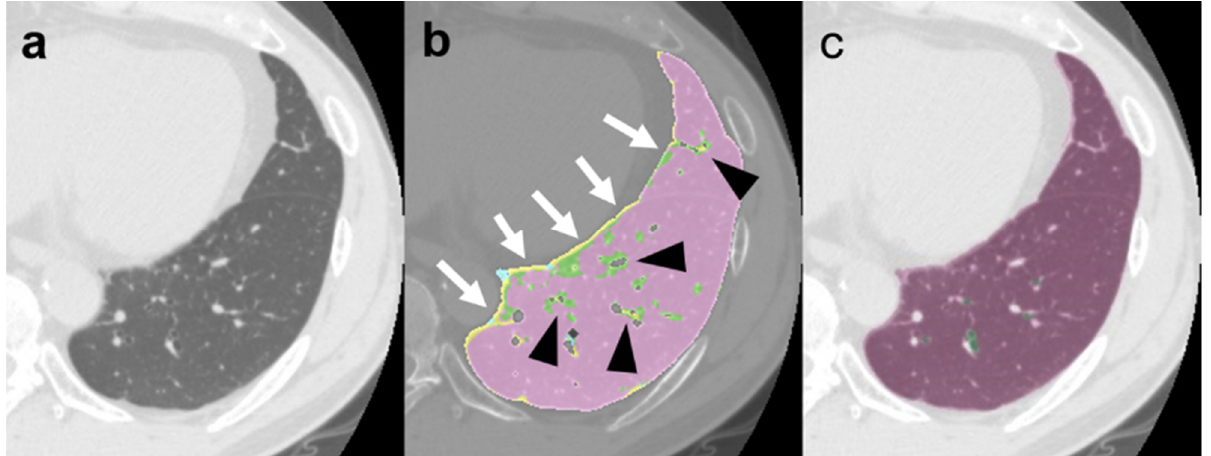
Figure 4. Images of a 57-year-old man with normal lungs. ( a ) Computed tomography (CT) image; ( b ) computer-aided diagnosis (CAD) method image; ( c ) deep-learning (DL)-based image. The conventional CT image ( a ) shows a normal lung. On the CAD method image ( b ), the pulmonary surface (white arrow) and perivascular area (black arrowhead) were misclassified as ground-glass opacity (G CAD ) and honeycombing (H CAD ), respectively. The DL-based analysis image ( c ) accurately classifies the normal lung area. The color code follows that described in the legend of Figure